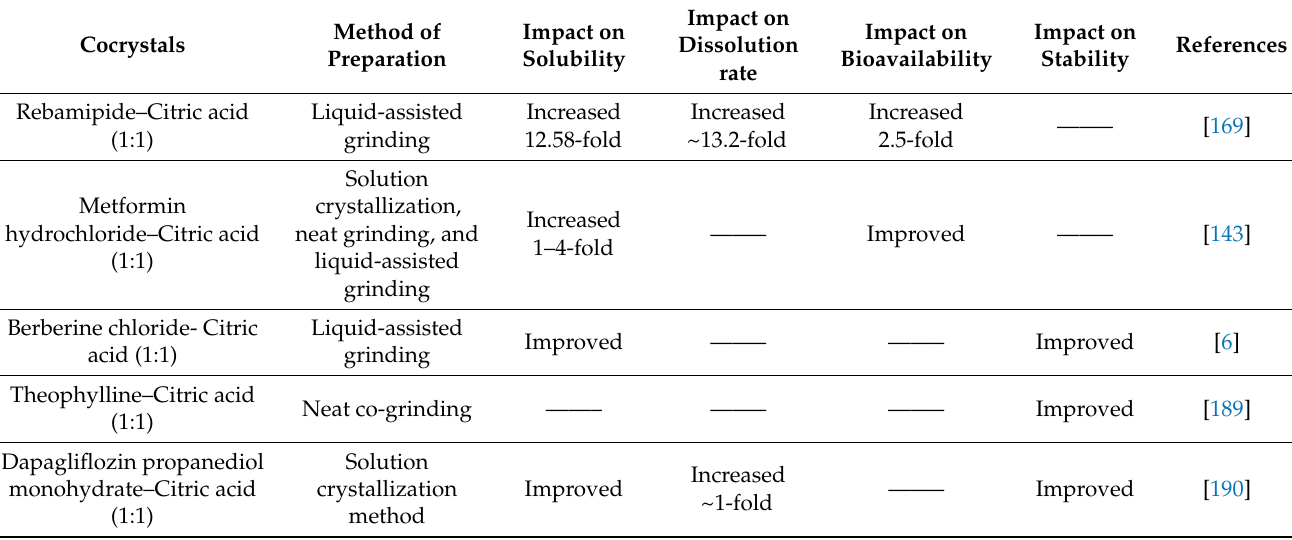
Table 11. Impact of citric acid as a coformer on drugs.